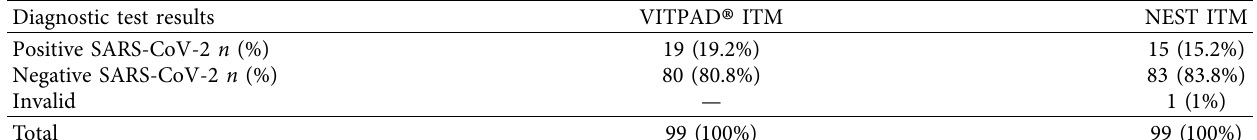
Table 2: COVID-19 diagnostic test results of samples stored in VITPAD ® and NEST ITM. Diagnostic test